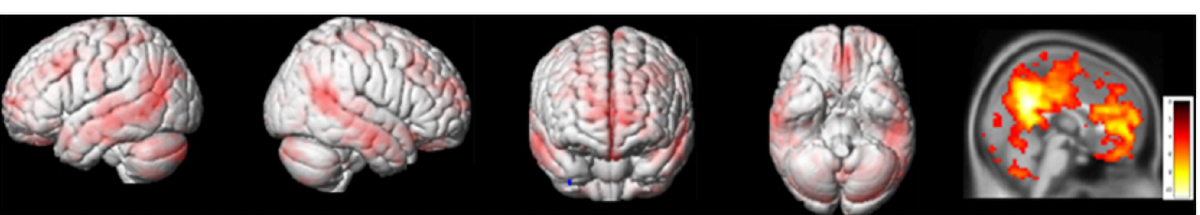
Fig 3. rs-fMRI of a healthy volunteer. Three-dimensional MNI surface renders and mean T 1 weighted image of rs-fMRI.